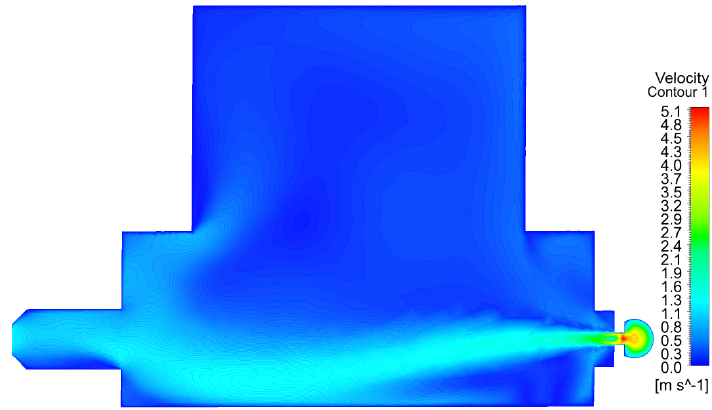
Figure 5. Velocity profiles across the vertical cross-section (XY plane) of the build chamber. Volume flow rate: 250 LPM.